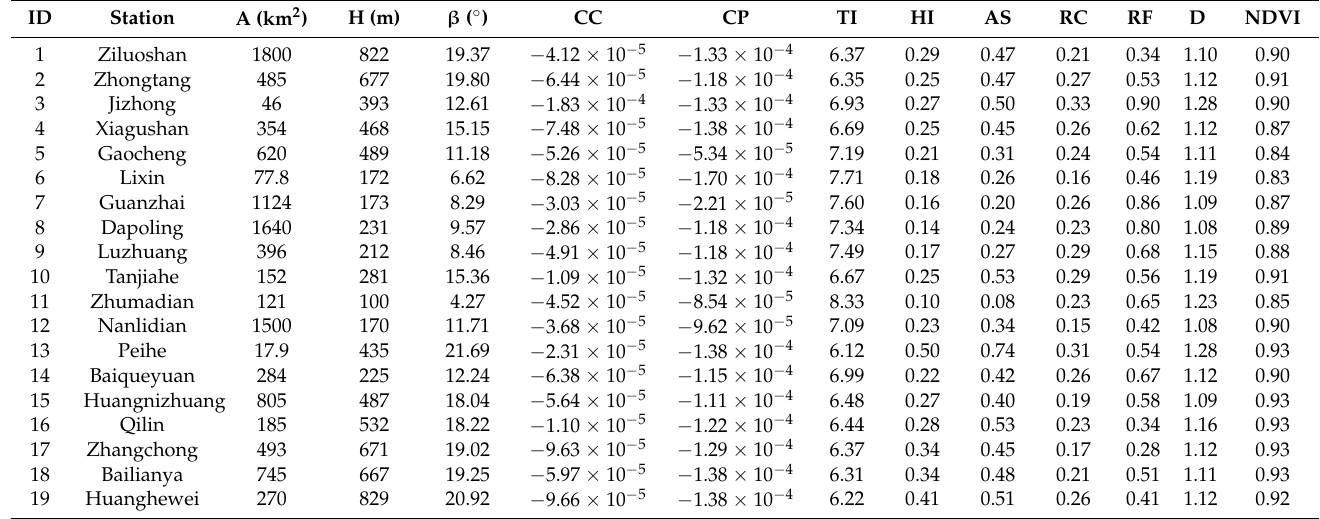
Table A2. 12 topographic features of 64